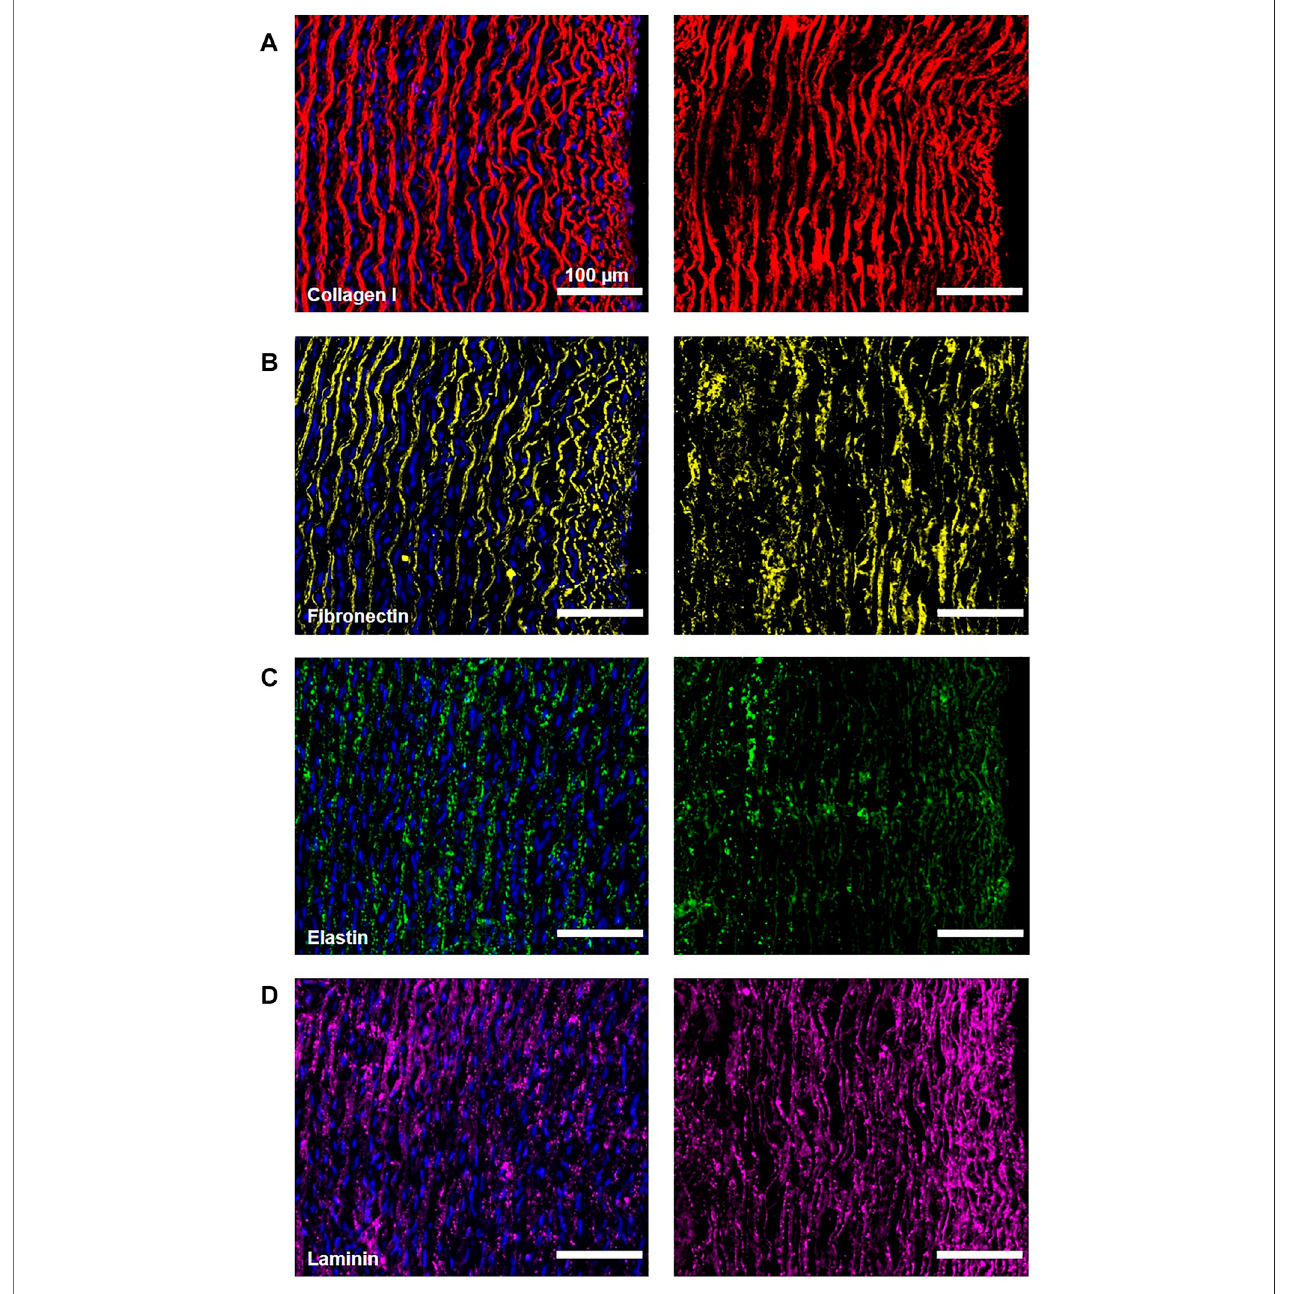
FIGURE5| ECMproteinsincarotidarteriesbefore(left)andafter(right)thedecellularizationvisualizedbyimmuno fl uorescence.Thevesselintimaisalwaysoriented ontheright-handsideoftheimage. CollagenIisstainedinred (A) , fi bronectin inyellow (B) ,elastiningreen (C) ,andlaminininmagenta (D) (allarti fi ciallyassignedcolors). Blue DAPI shows nuclei in the native artery, while absence in decellularized tissue is indicative of complete cell removal. The scale bar is 100 μ m for all the images.